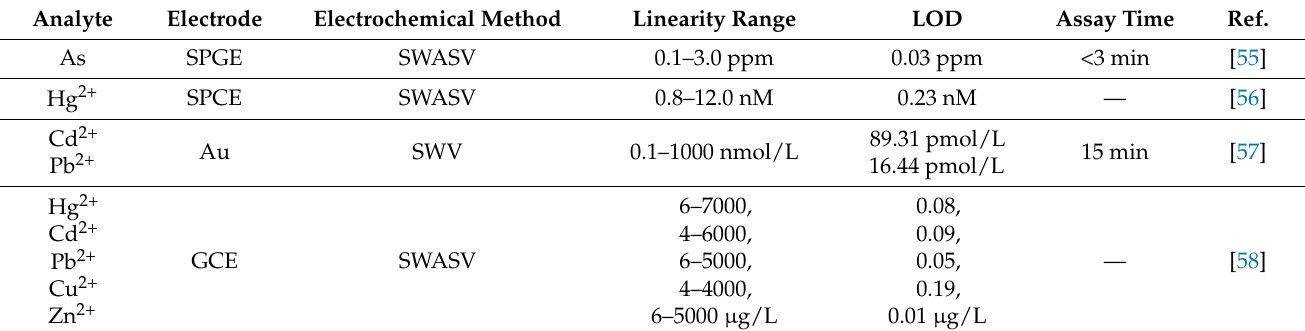
Table 6. Electrochemical biosensors for heavy metal